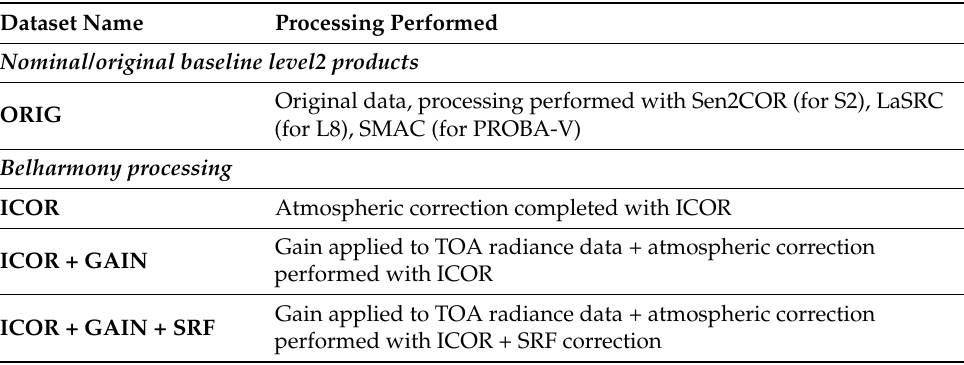
Table 2. Naming of datasets used in this study and description of the processing performed. Dataset